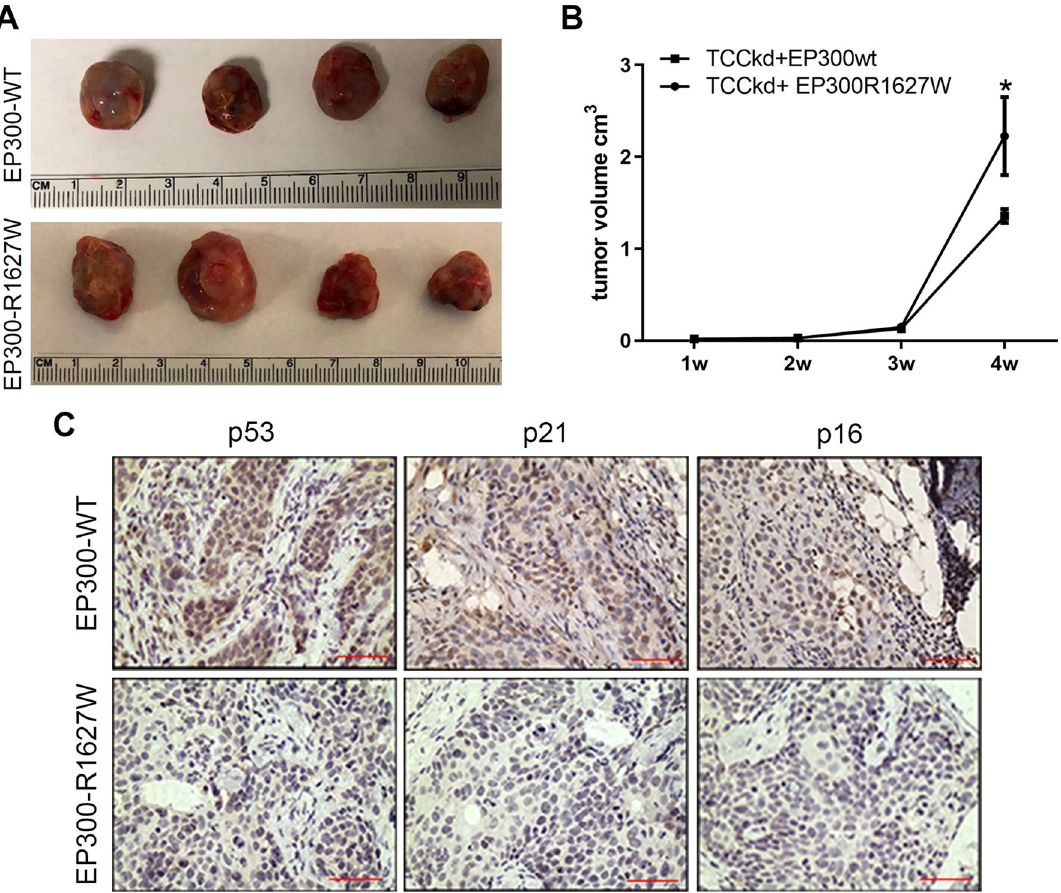
Fig. 6 EP300-R1627W mutation promotes the growth of bladder cancer in vivo. A Images showing the size of the tumors that developed in mice of two groups. B Tumor volumes of two groups for 4 weeks after injection of EP300-wt-transfected and EP300-R1627W-transfected TCC-SUP-EP300kd cells, respectively. C Immunohistochemical analysis of p53, p16 and p21 expression level in harvested